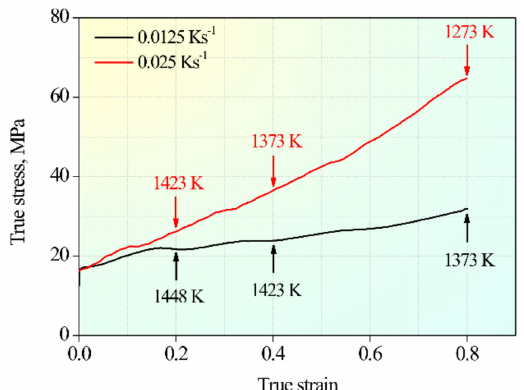
Figure 1. Flow curves of 18Mn18Cr0.6N steel compressed at 10 − 4 s − 1 under different cooling rate